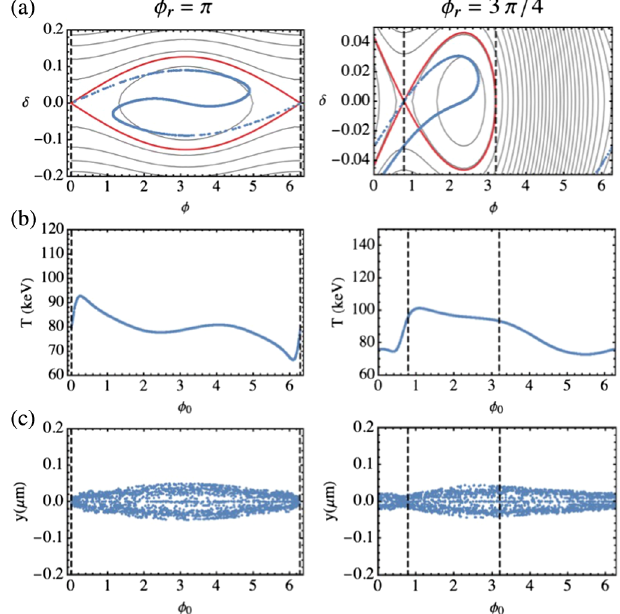
FIG. 5. Plots showing the (a) final longitudinal particle phase space superimposed with the Hamiltonian separatrix (in red), (b) energy spectrum as a function of the injection phase ϕ 0 with a stable accelerating region marked by vertical lines, and (c) trans- verse position y vs injection phase. Plots on left and right correspond to resonant phases ϕ r ¼ π and ϕ r ¼ 3 π = 4 , respec- tively. The left column corresponds to a nontapered structure, while the right column corresponds to a tapered